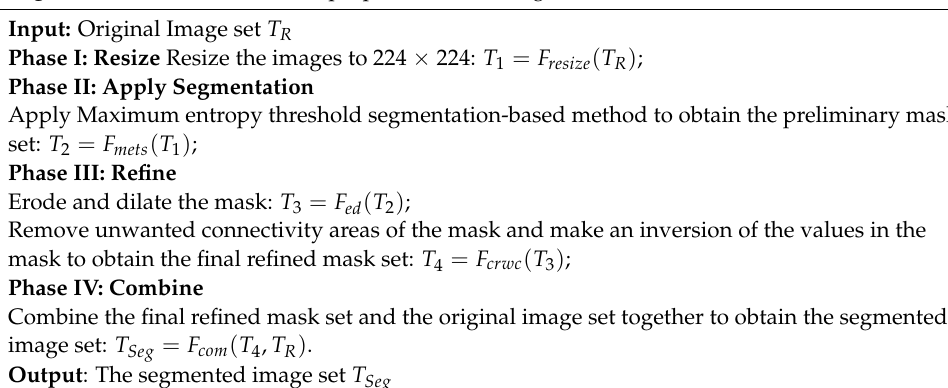
Algorithm 1 Pseudocode of our proposed COVID-Seg